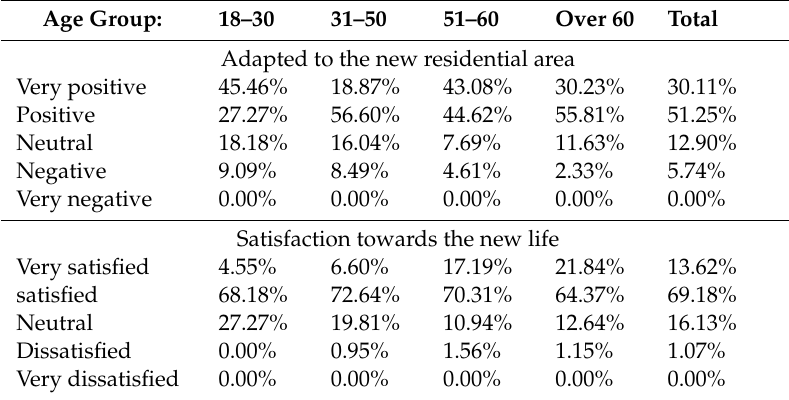
Table 4. Adaptation to, and satisfaction with the new lifestyle.